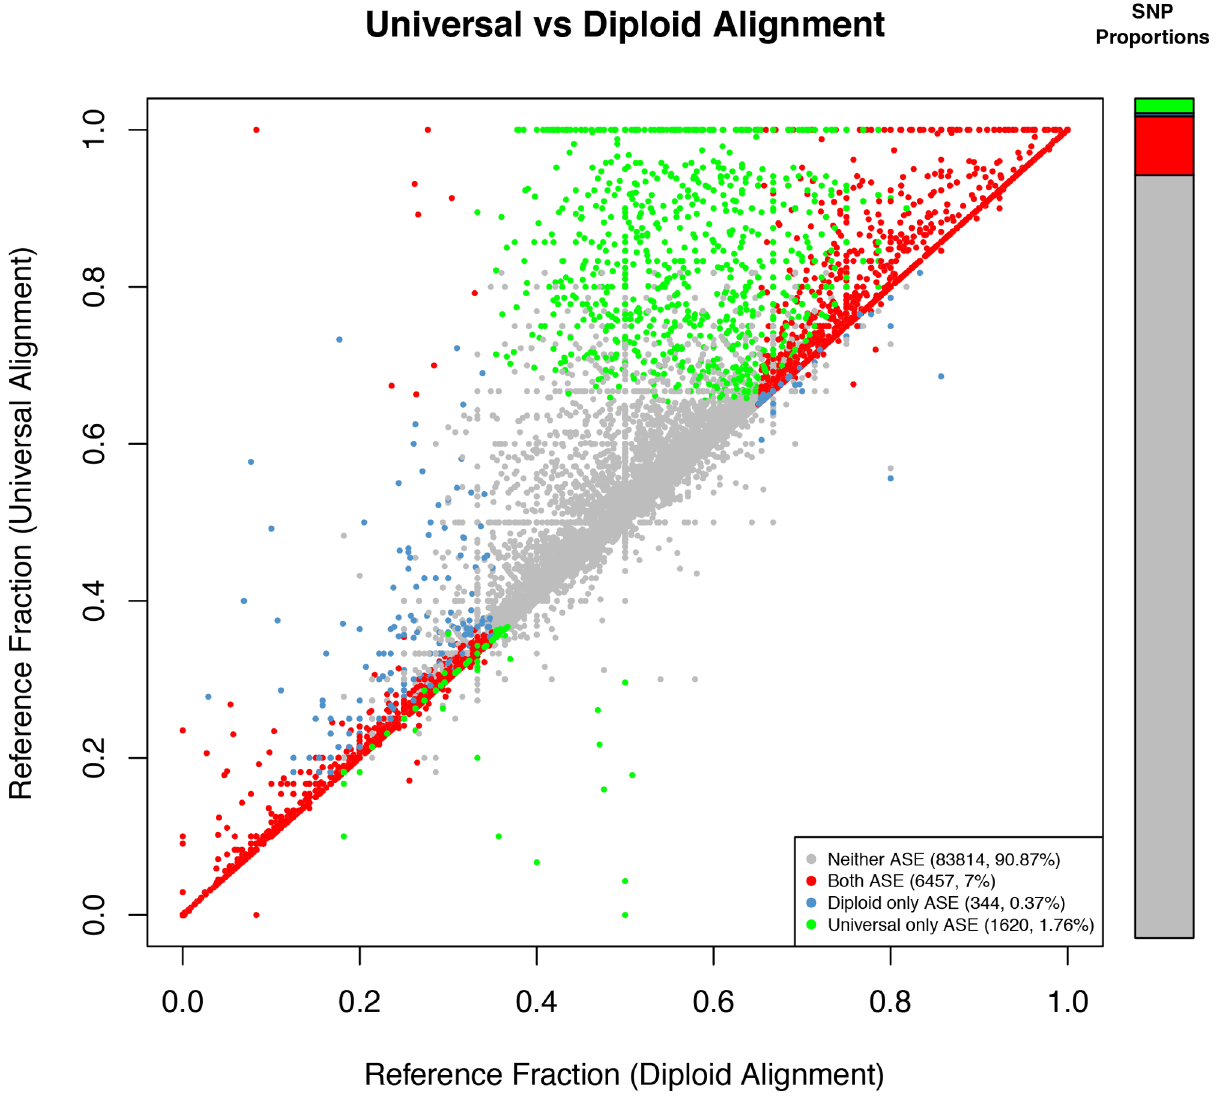
Fig 1. SNP reference fraction correlations between universal and diploid alignment methods. Each point is a SNP, coloured according to its ASE classification in both alignment methods. Bar plots indicate the proportion of all SNPs in the plot (left), and the proportion of all SNPs classified as ASE in any method (right). Aligning RNA-seq reads to personalised haplotype references then choosing the alignments with the smallest edit-distance resulted in more balanced allelic expression ratios than aligning to the universal reference.